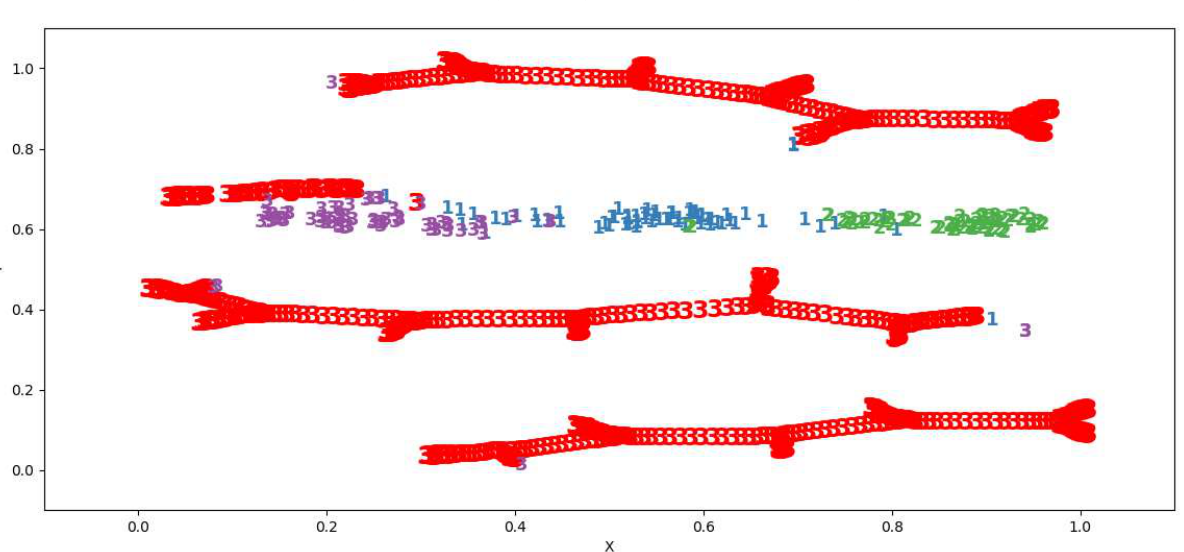
Table 11. Number of successful adversarial attacks on classifiers.